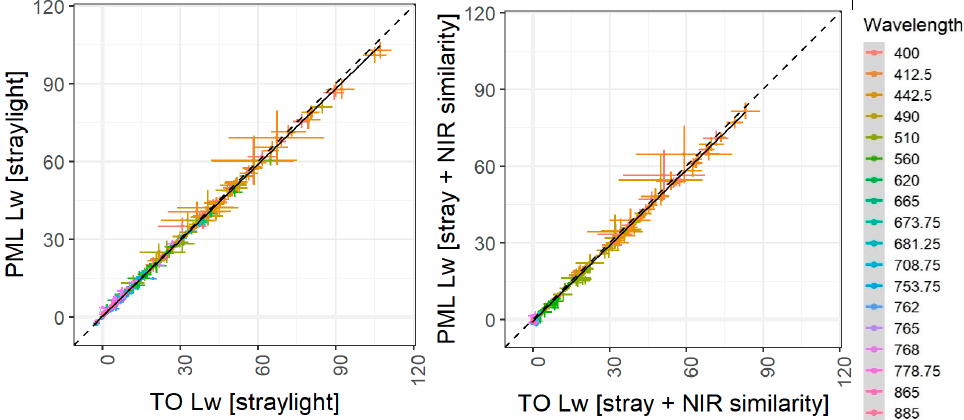
Figure 12. Comparison between TO and PML 𝐿w after straylight (left) and straylight + NIR similarity correction over all OLCI’s band. The comparison in each band separately can be found in Figure A6 for straylight correction.